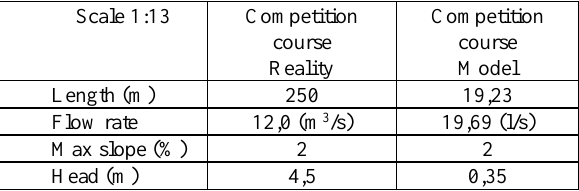
Table 1. Parameters of the full sized and modelled courses